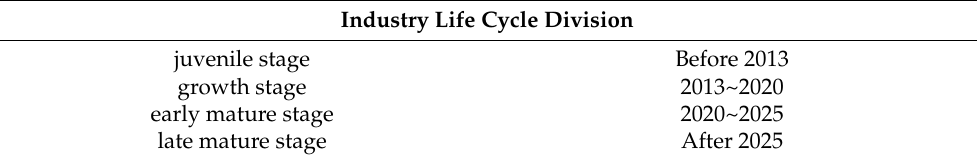
Table 2. Life cycle stages of the CPV industry.